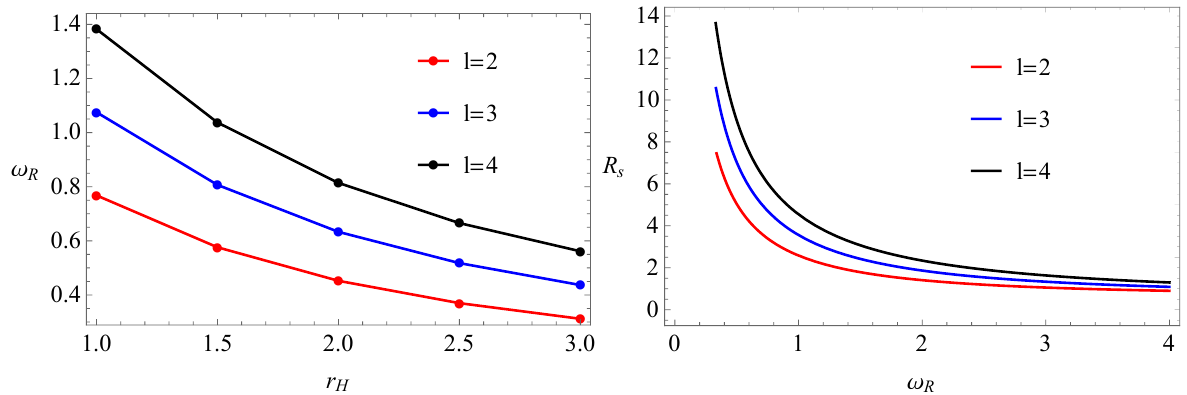
Figure 7. Left panel : The real part of QNMs as a function of the horizon radius for different l . We have set a / M = 0.65 and b / M = 0.5. Right panel : The typical shadow radius (Equation (71)) as a function of the real part of QNMs with a / M =